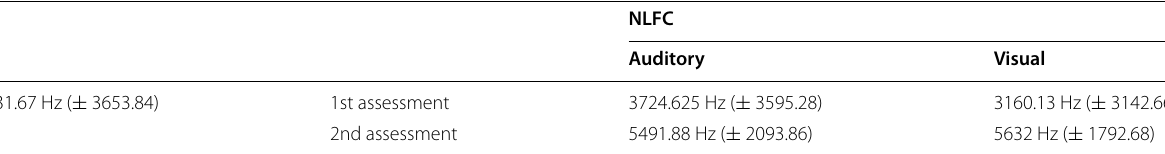
Table 6 Mean of F2 onset in /fa/ syllable in TD and NLFC